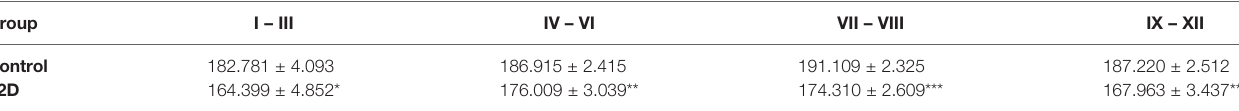
TABLE 2 | Tubule diameter ( m m) for different stages of sperm production in the testes. Group